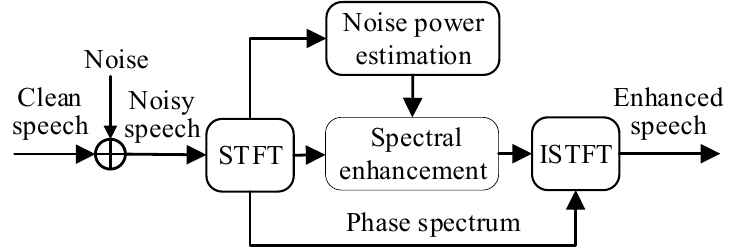
Figure 2. The statistical-based speech enhancement algorithm.